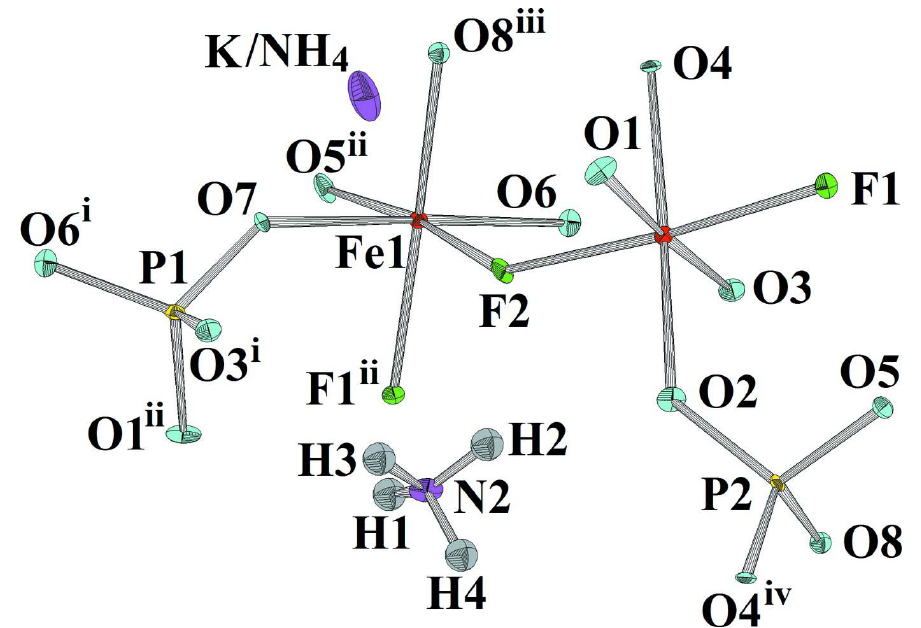
Figure 3 Coordination environment of Fe and P atoms, with displacement ellipsoids drawn at the 50% probability level (symmetry codes: (i) x, 1+y, z; (ii) 1/2-x, 1/2+y, 1/2+z; (iii) -1/2+x, 1/2-y, z; (iv) 1/2+x, 1/2-y,